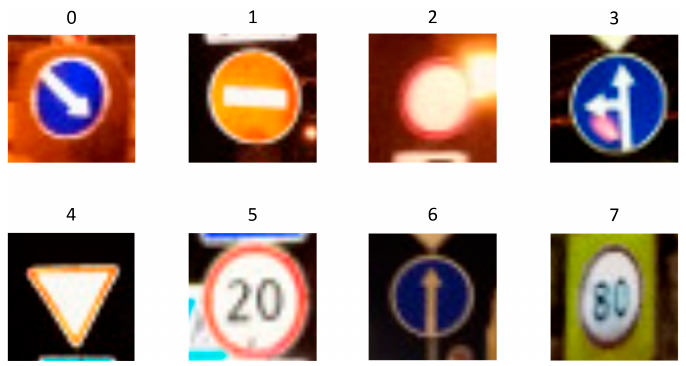
Figure 13. The auto-numbered traffic sign test images.